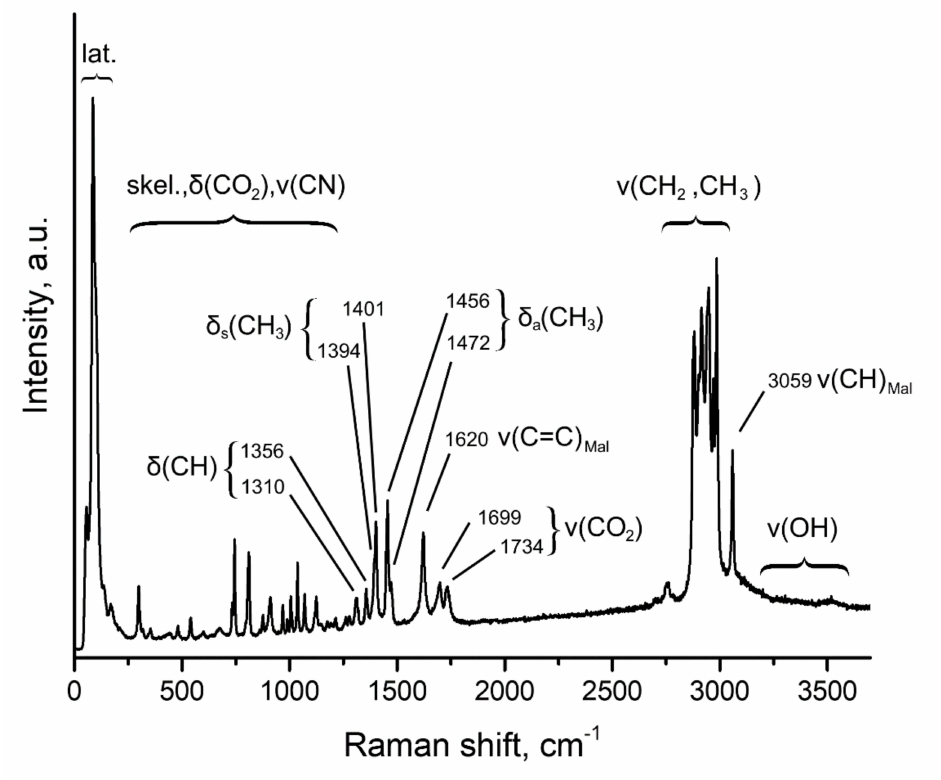
Figure 3. Experimental Raman spectra bands assignment in LLHM crystal structure at 298 K. Calcu- lated gas-phase vibrational spectra are presented in Figure S1 (please see Supplementary